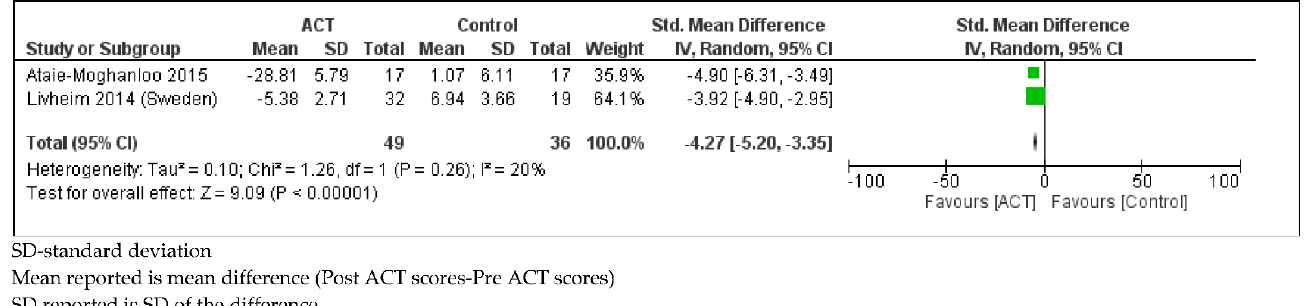
Figure 5. Forest plot comparing depression scores between children with SHCN who received ACT and children with SHCN who received no treatment.